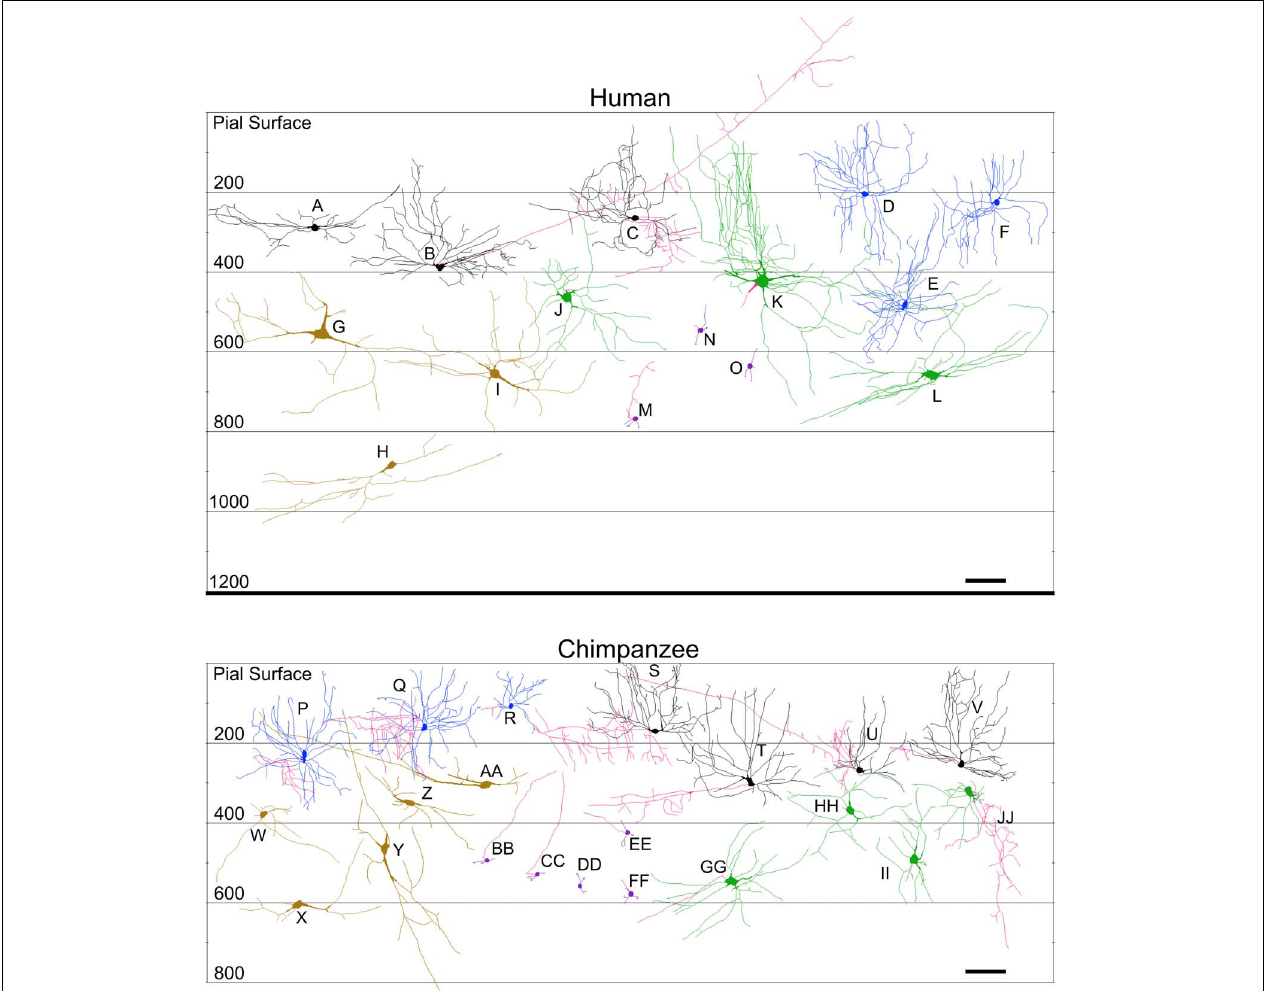
FIGURE 11 | Neurolucida tracings of neurons in the cerebellar cortex of thehuman(top)andchimpanzee(bottom)indicatingrelativesomadepth from the pial surface (in µ m). Basket neurons (A–C; S–V) ; stellate neurons (D–F;P–R) ;Lugaroneurons (G–I;W–AA) ;Golgineurons (J–L ; GG–JJ) ;granule